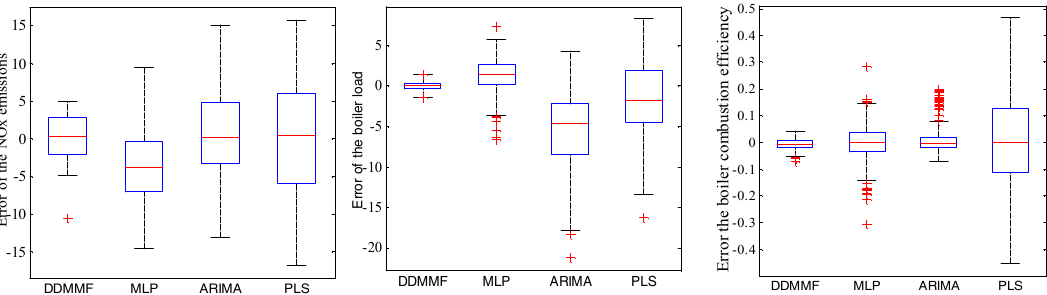
Figure 4. The prediction errors obtained from different prediction models for operating condition 1. Table 4. The prediction evaluation indicators of different objects for different models in operating condition 1.